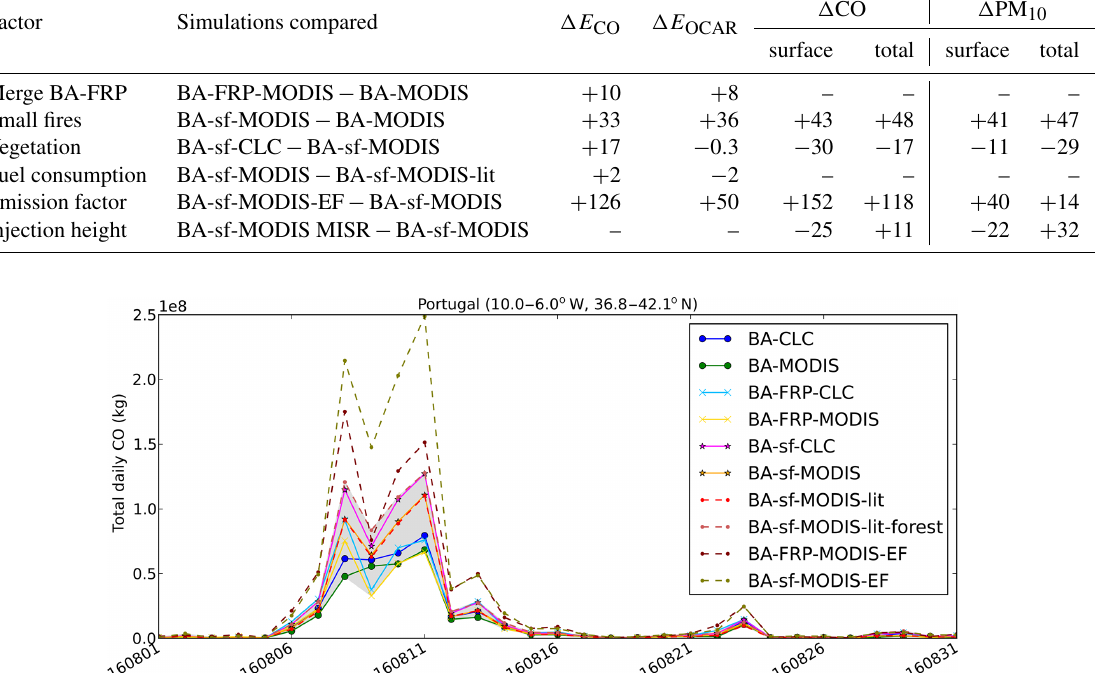
Figure 6. Total daily CO emissions during August 2016 over northern Portugal. Results using different APIFLAME configurations are shown in different colors (cf. Table 2). The shaded area shows the total spread for experiments modifying the dry matter burned (without impact of emission